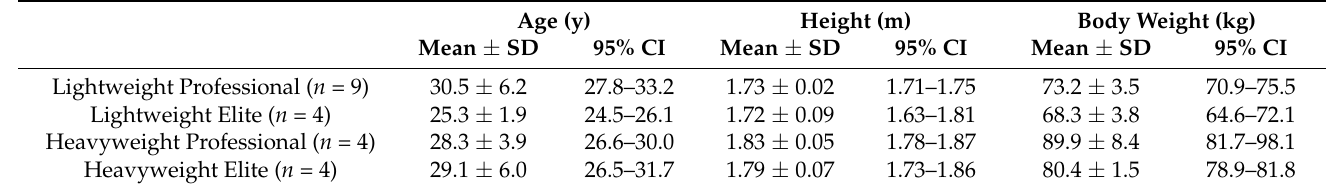
Table 1. Characteristics of the MMA athletes according to their competitive level and weight class. Age (y) Height (m) Body Weight (kg) 95%